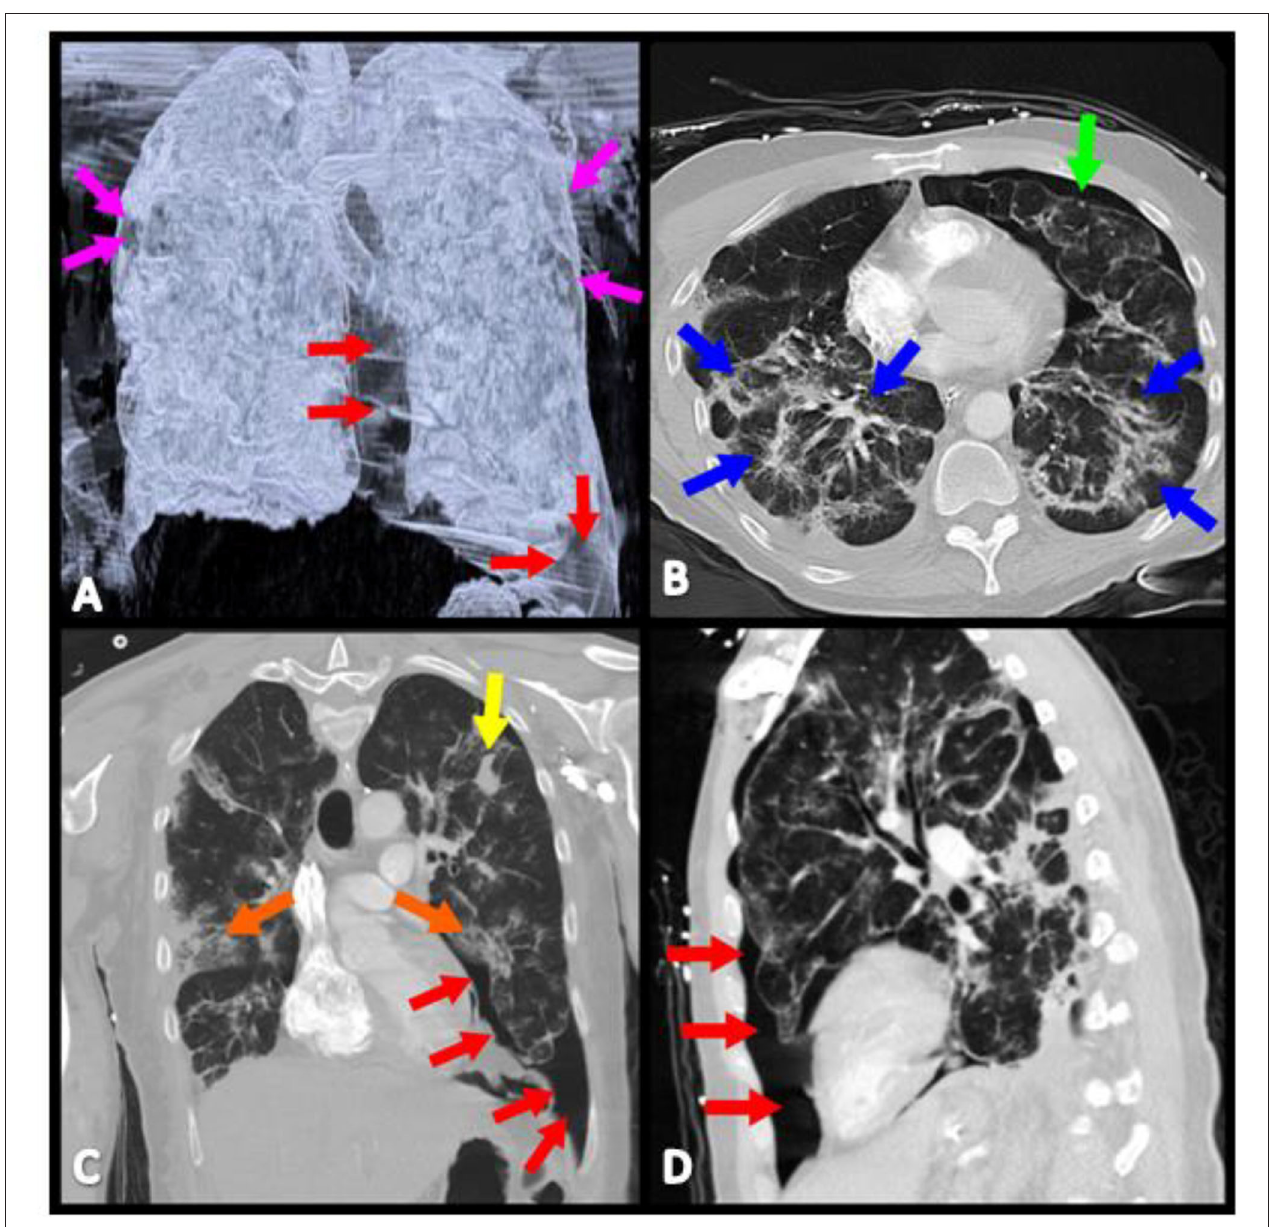
FIGURE 1 | Contrasted CT scan reveals bilateral lung disease, characterized by: (A) Bilateral pneumothoraces (magenta, red, and green arrows). (B) Interstitial, diffuse infiltrates (blue arrows). (C) Isolated areas of consolidation (orange and yellow arrows). (D) Left lung pneumothorax has its largest prominence in the inferior costophrenic sulcus (red